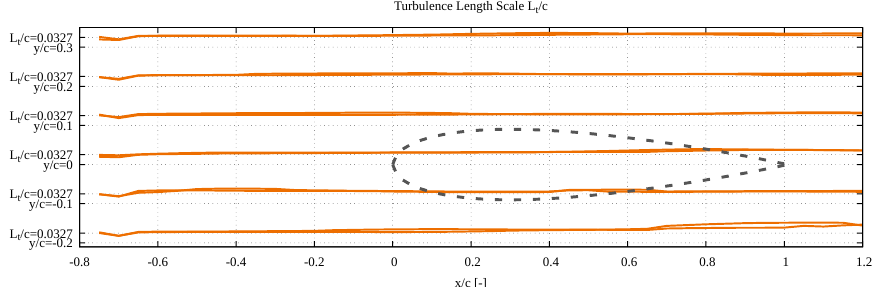
Figure 5. Development of integral turbulence length scale along an empty domain. The dashed lines indicate where an object like an airfoil could have been